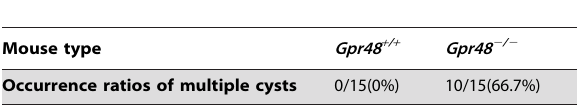
Table 3. The incidence of multiple cysts of the kidneys in Gpr48 + / + and Gpr48 2 / 2